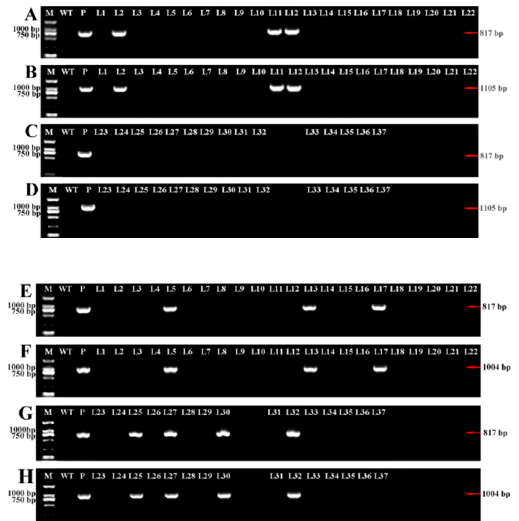
Figure 5. PCR (polymerase chain reaction) identification of OE- LpABCB21 ( A – D ) and OE- LpPILS7 ( E – H ) positive lines. ( A , C , E ) and ( G ) are the cloning results of NPT II gene (817 bp); ( B ) and ( D ) are the cloning results obtained using the primers against the 35S promoter and LpABCB21 (1105 bp); ( F ) and ( H ) are the cloning results obtained using the primers against the 35S promoter and LpPILS7 (1004